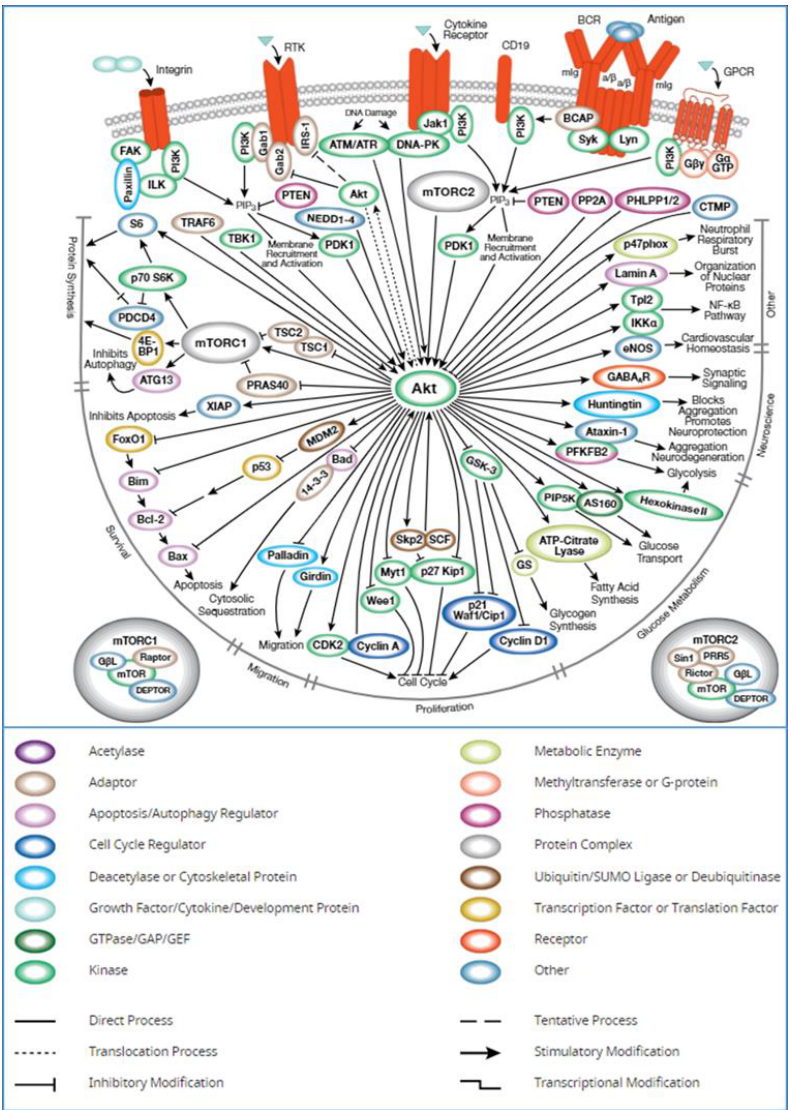
Figure 2. PI3k/AKT signaling pathway. Illustration reproduced courtesy of Cell Signaling Technology Inc. (www.cellsignal.com, accessed on 30 October 2022).